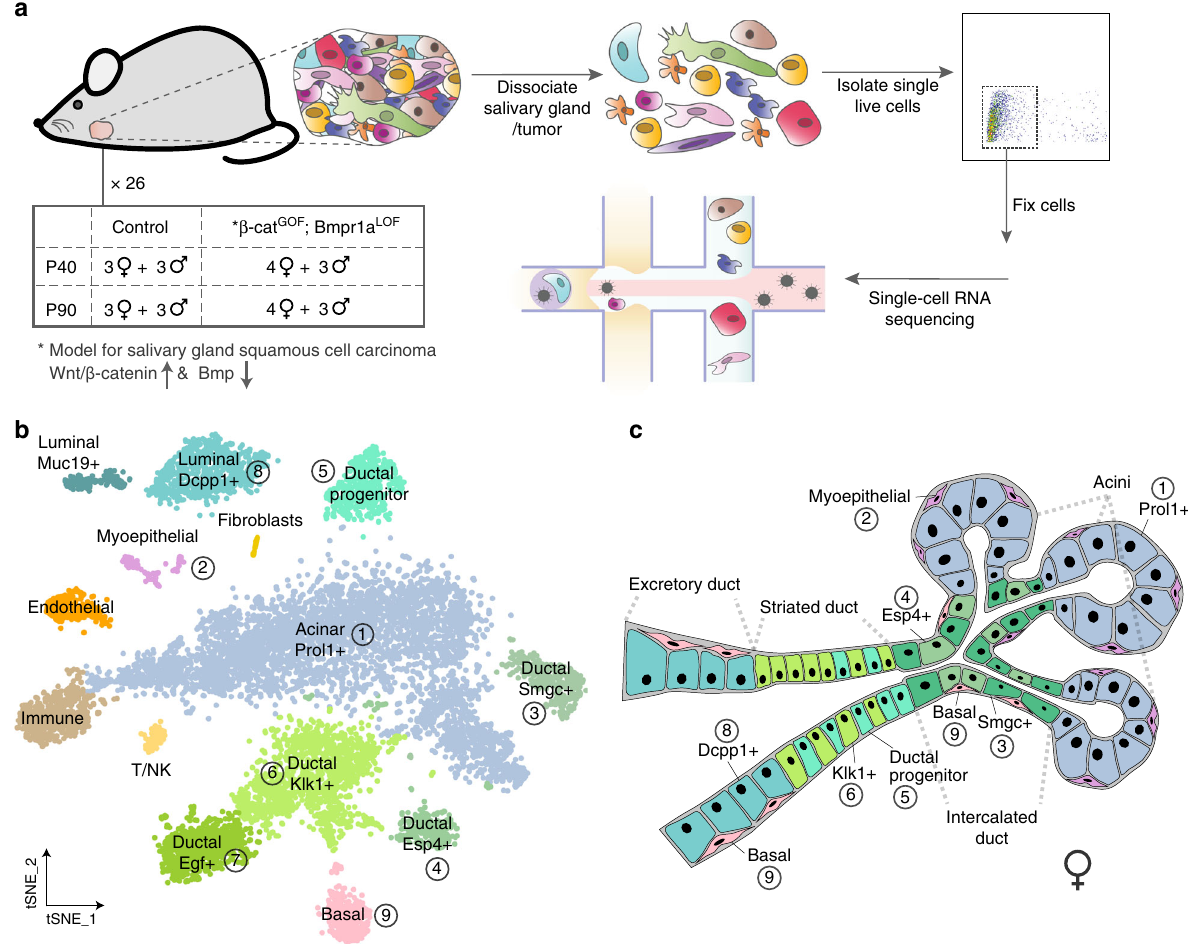
Fig. 1 A comprehensive salivary gland cell atlas. a Experimental strategy to systematically dissect the cellular diversity in solid tumors. Submandibular salivary glands were individually dissected, dissociated and single, live cells isolated by FACS. Cells were immediately fi xed in methanol and further processed to pro fi le their transcriptomes by a high-throughput droplet-based single-cell approach. Each biological replicate corresponds to the cells of one submandibular gland from a control or tumor-bearing, female or male mouse at a de fi ned stage as indicated. b tSNE representation of single-cell data from control salivary glands shows that cells cluster into 14 groups based on their transcriptome similarity. Clusters are colored and shaded according to the expression of both novel and known marker genes for epithelial and non-epithelial cell types. Turquoise — blue — green: luminal — acinar — ductal, pink: basal, purple: myoepithelial, shades of brown, yellow and orange: non-epithelial (immune, endothelial, fi broblasts, T/NK). c Anatomical sketch of the female submandibular gland based on single-cell transcriptome data, available literature (see text for references) and validations in tissue sections